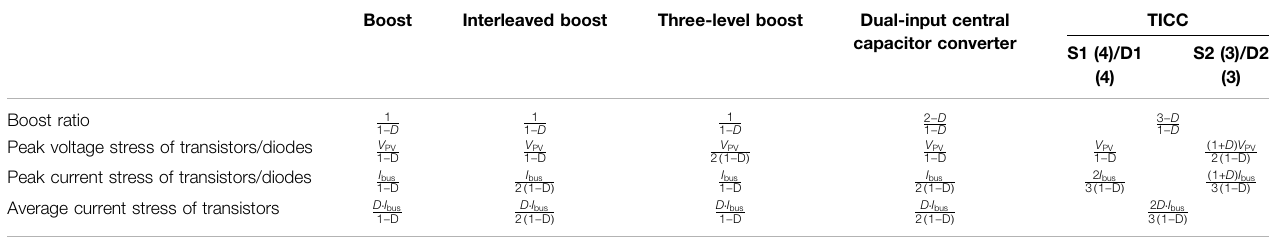
TABLE 4 | Comparison of semiconductor device stress.